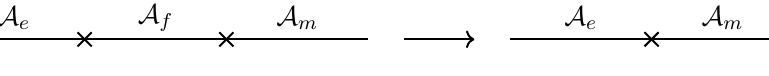
Figure 4 . Fusion of ef and fm junctions.